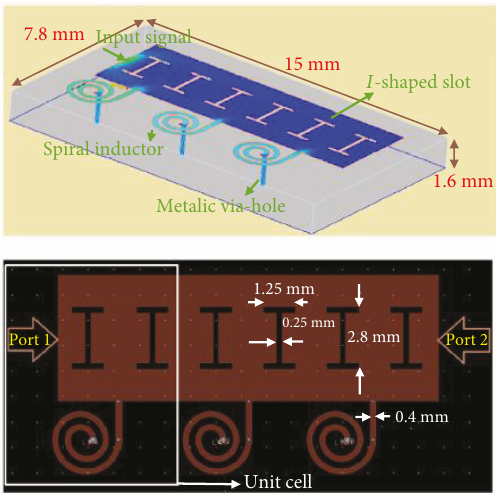
Figure 14: A low-pro fi le UWB antenna used a right/left- (CRLH-) handed metamaterial